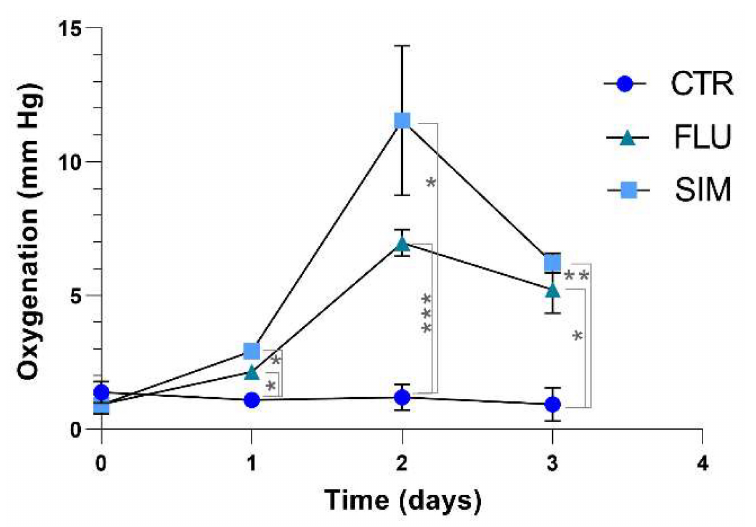
Figure 5. Effect of daily treatment with statins (20 mg/kg) on tumor oxygenation as measured by EPR oximetry. Simvastatin (44 µ mol/kg), fluvastatin (46 µ mol/kg). Data are shown as means ± SEM, (*) p < 0.05, (**) p < 0.01, (***) p < 0.001, two-way ANOVA, n =